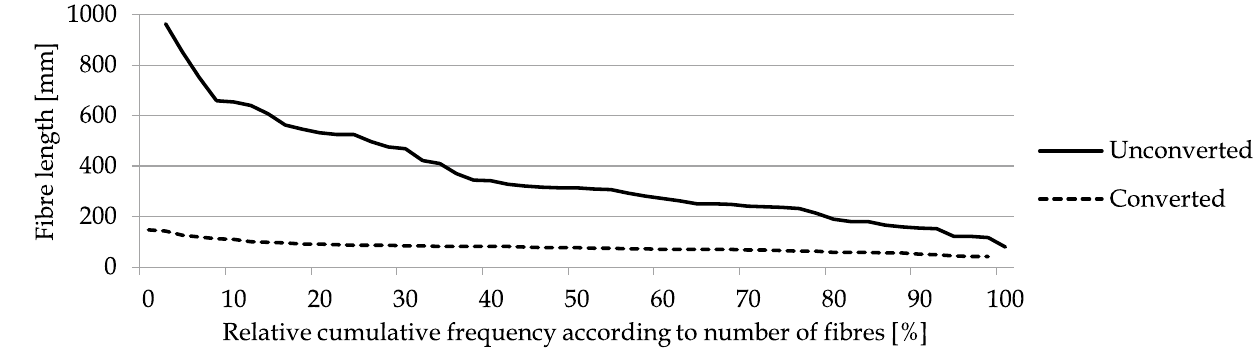
Fig. 10 Fibre length distribution of converted and unconverted metal staple fibres